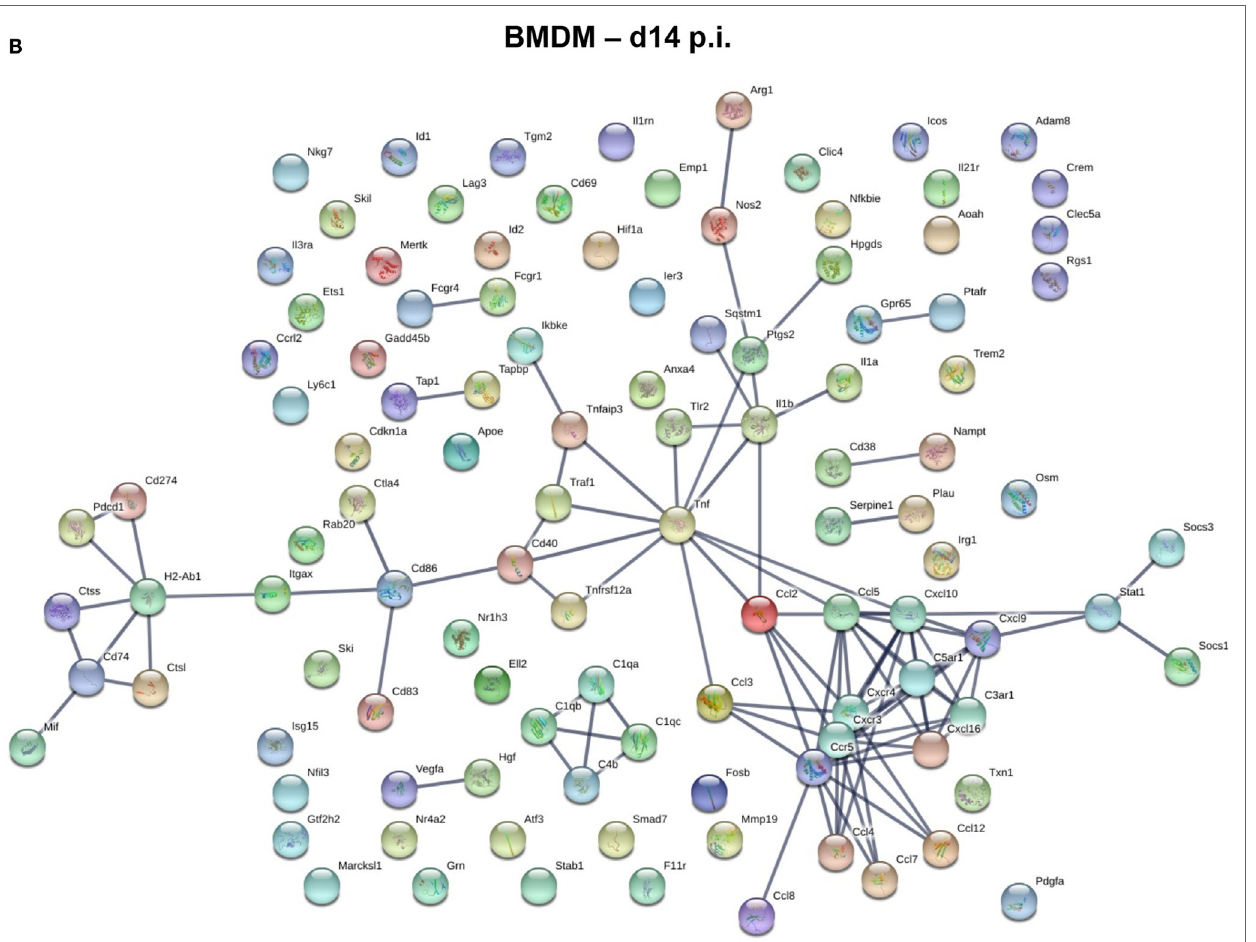
FigUre 6 | Upregulated gene network within central nervous system (CNS) infiltrating macrophages at d5 and d14 p.i. Protein–protein network constructed based on genes upregulated by at least twofold in infiltrated bone marrow-derived macrophage (BMDM) at days 5 (a) and 14 (B) p.i. compared to naïve levels were analyzed using Ingenuity IPA